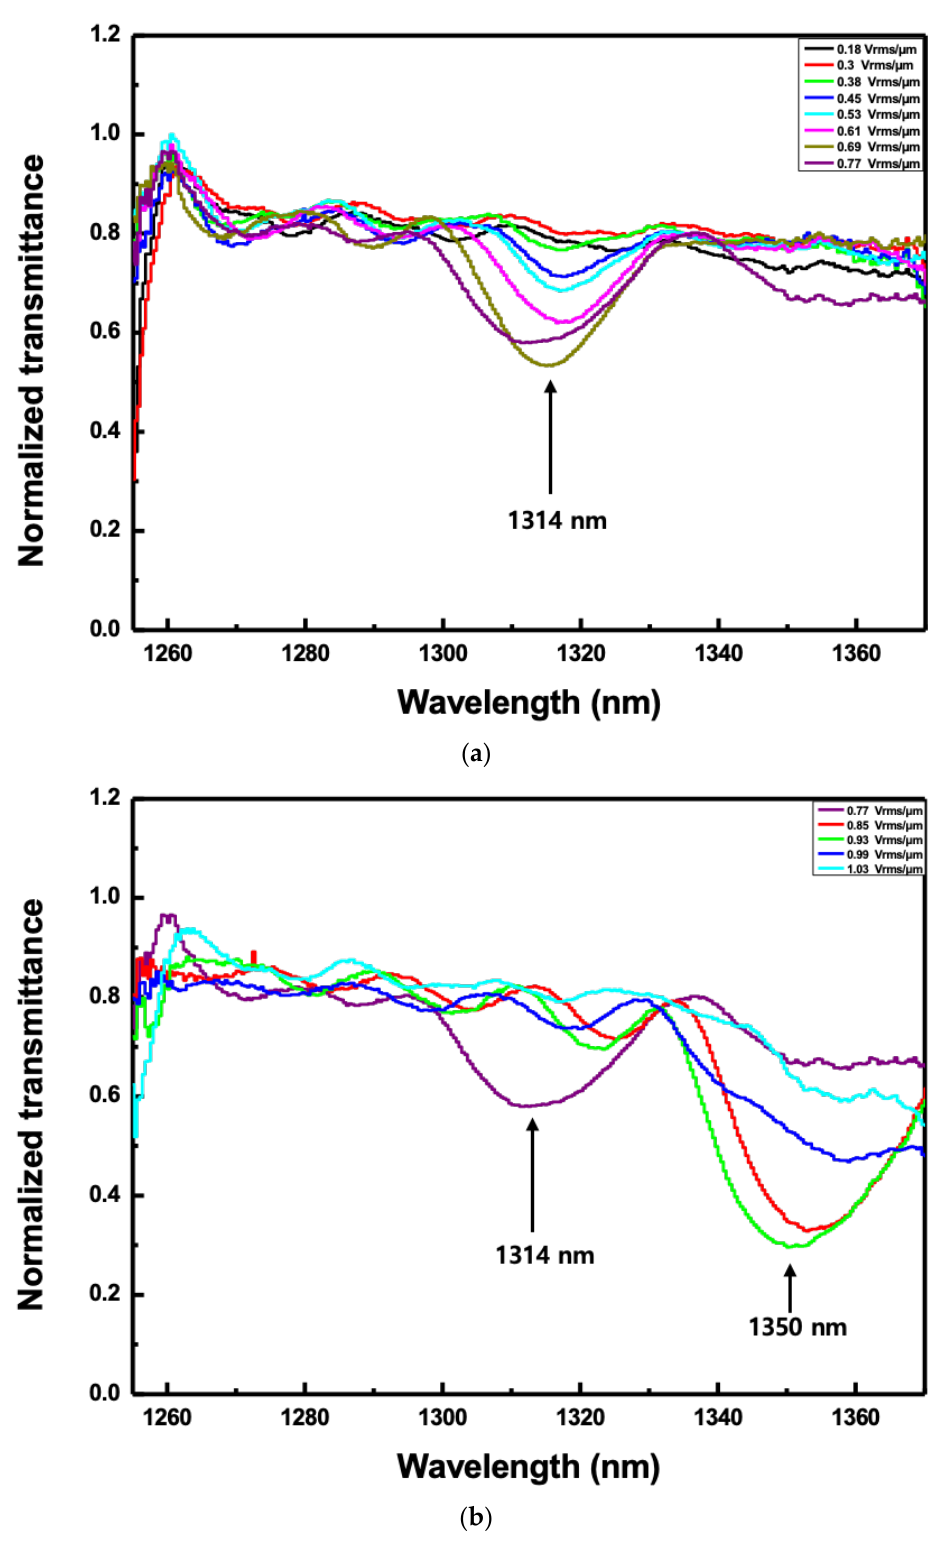
Figure 6. The normalized transmitted spectra according to the applied electric field when the angle of incidence to the CLC cell was fixed to 20 o . ( a ) The electric field ranged from 0.18 V rms /μm to 0.77 V rms /μm and ( b ) the electric field ranged from 0.77 V rms /μm to 1.03 V rms /μm.